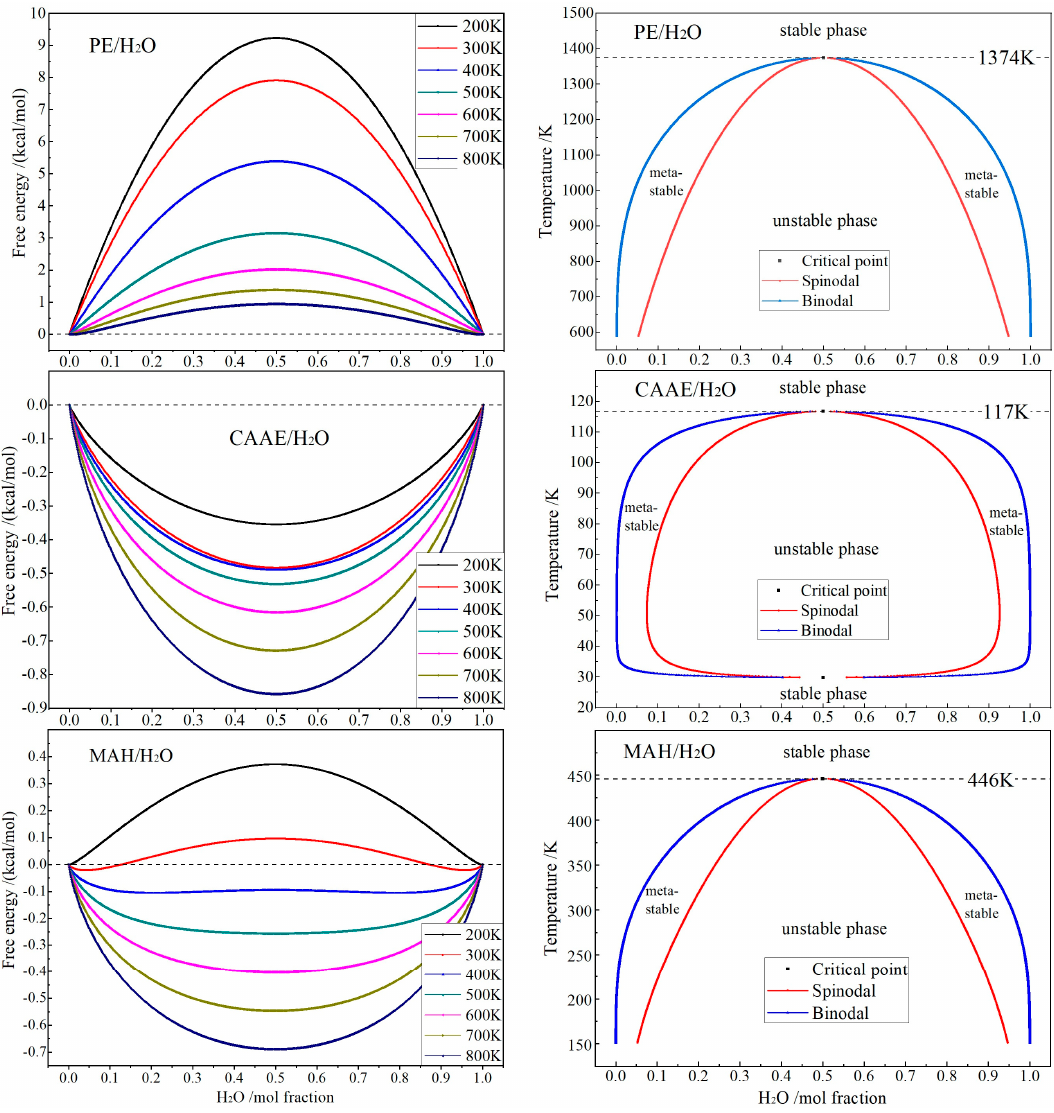
Figure 6. Free energy ( left panels ) at 200–800 K and phase diagram ( right panels ) of PE/H 2 O, CAAE/H 2 O and MAH/H 2 O binary molecular mixtures.